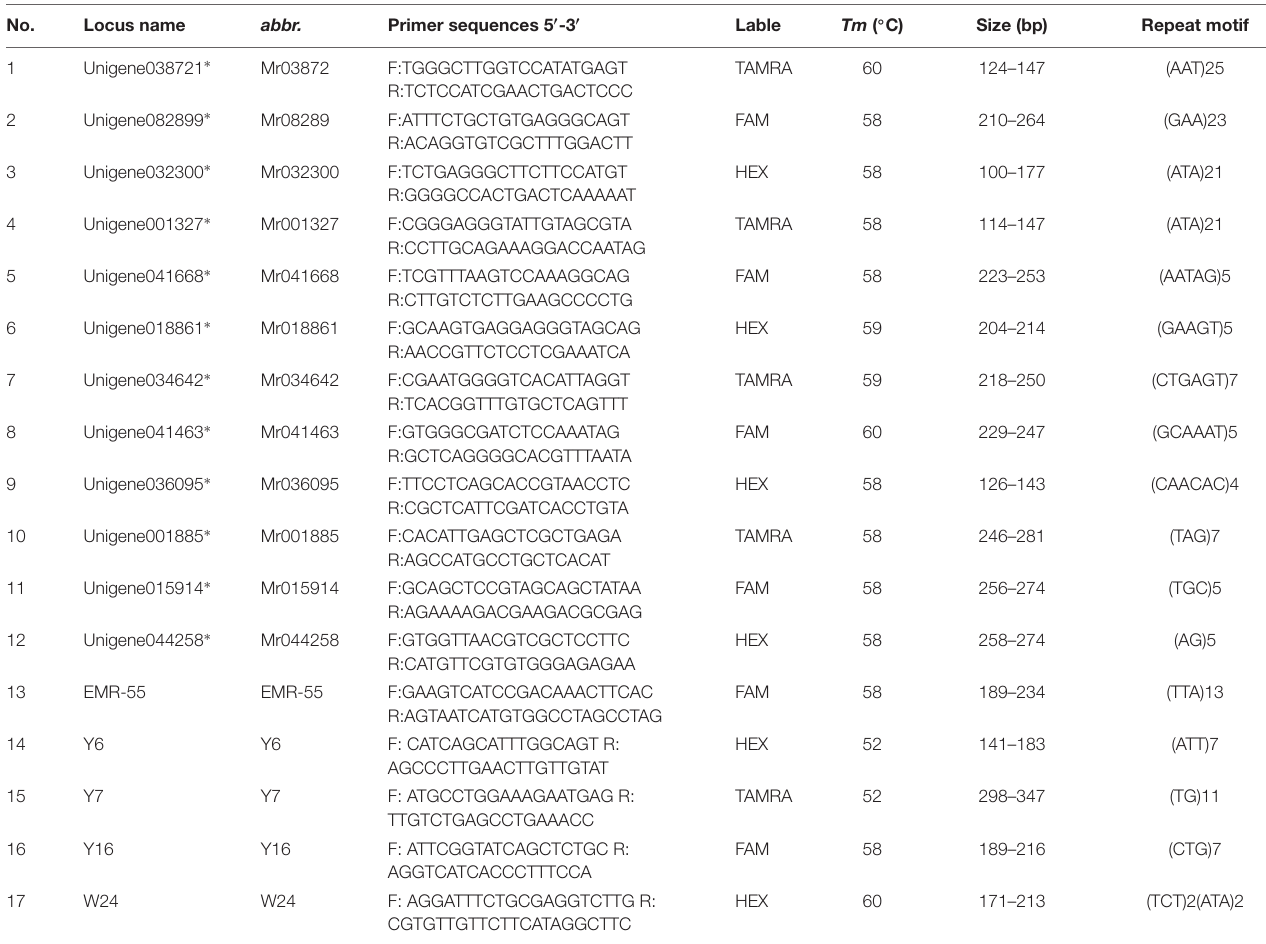
TABLE 2 | Primer sequence and annealing temperature for microsatellite marker